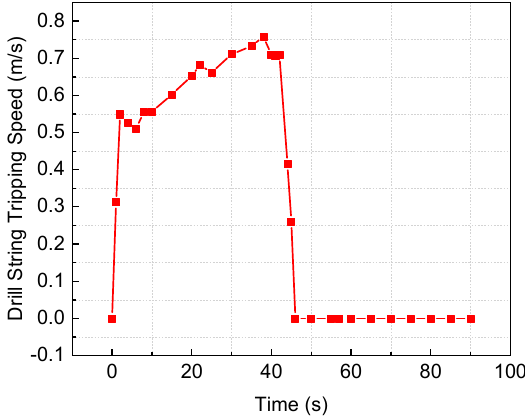
Figure 8. Drill string tripping speed vs. time.